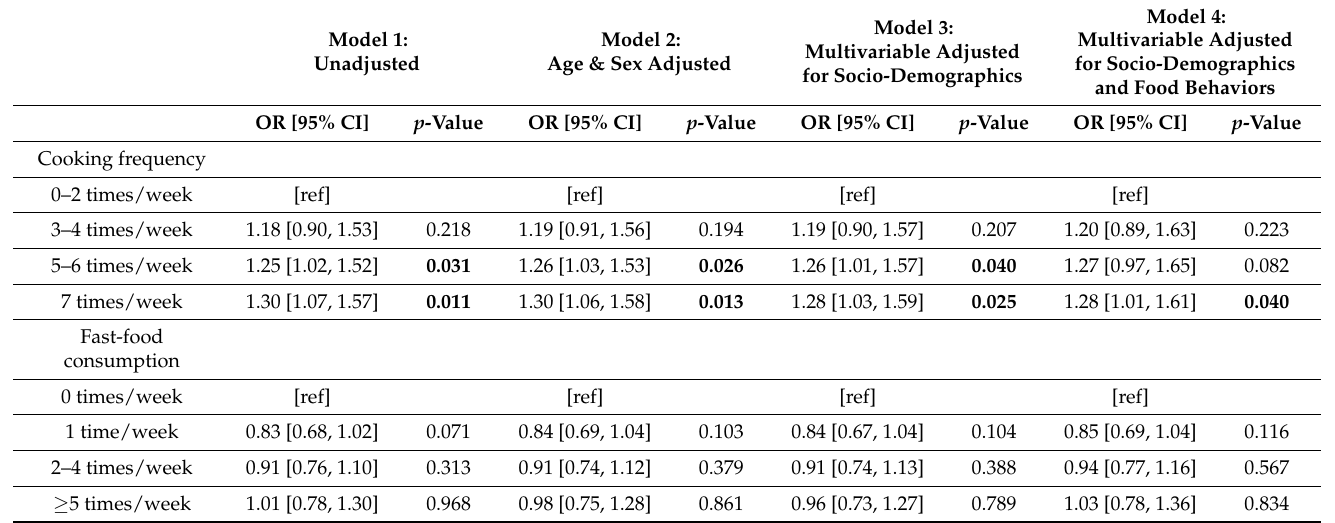
Table 3. Odds of being in highest quintile of GHGE per 2000 kcal by cooking frequency and fast-food frequency, NHANES 2007–2010. Model 4: Model 3: Model 1: Model 2: Multivariable Adjusted Multivariable Adjusted Unadjusted Age & Sex Adjusted for Socio-Demographics for Socio-Demographics and Food